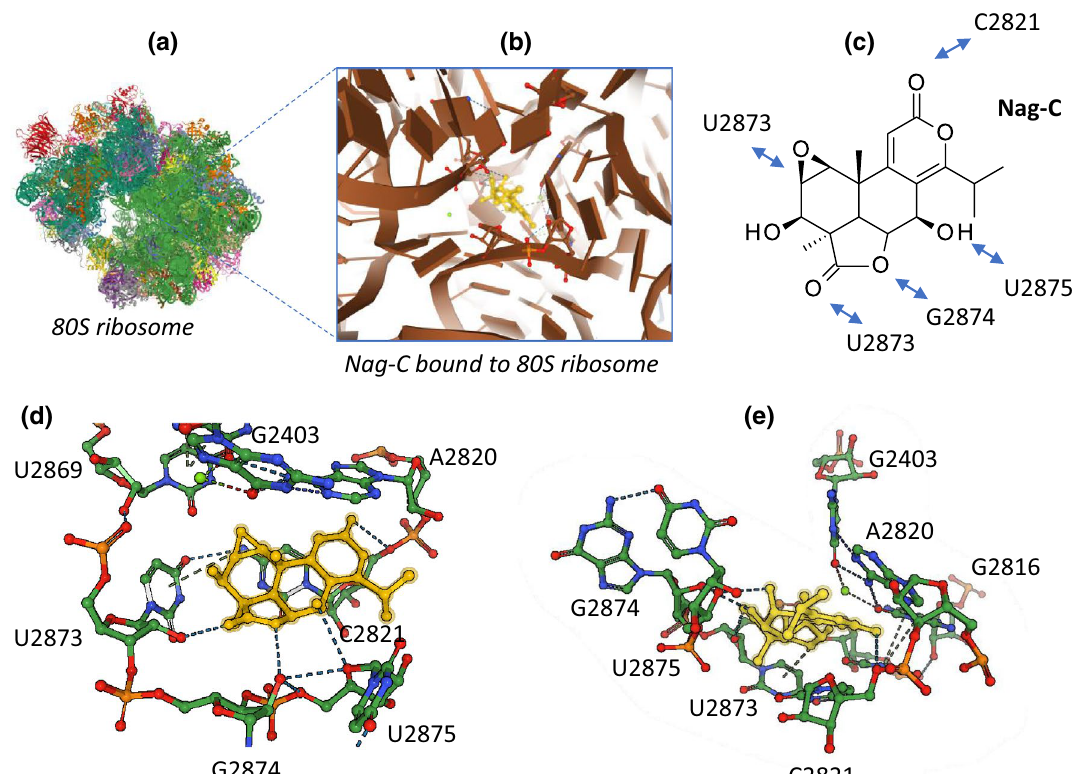
Fig. 6 Illustration of Nag-C bound to the 80S ribosome (PDB code U52) [50]. a The entire yeast 80S ribosome, b a focused view of Nag-C at the heart of the ribosome, blocking the peptidyl transferase center, c the molecular contacts (H-bonds and p stacking interactions)